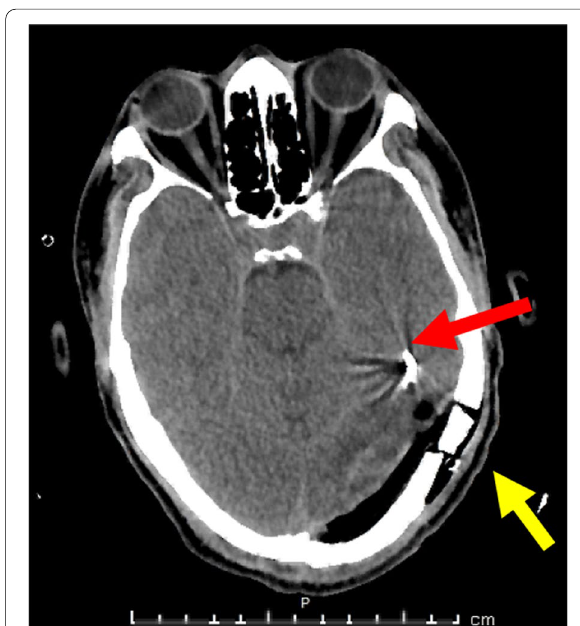
Fig. 9 CT Postoperative of AVM case. No evidence of residual nidus is present. It shows the metallic artifact of the clip (red arrow) which used to clip the feeding artery. Note: the segmented bone flab (yellow